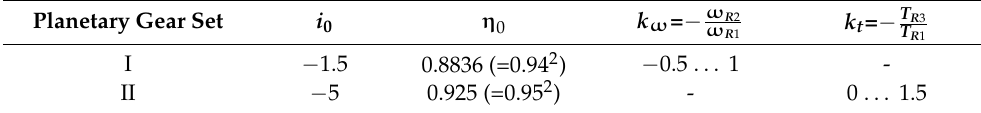
Table 4. Input data for the numerical simulations of the analytical model. Planetary Gear